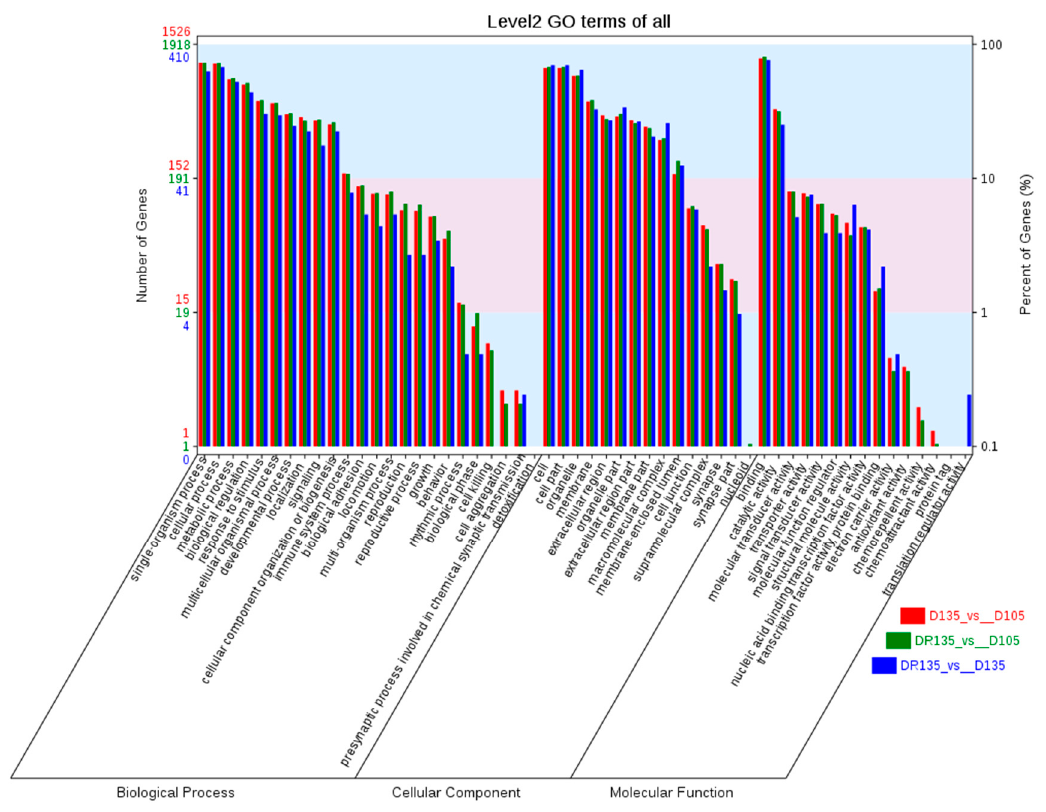
Figure 4. A Gene Ontology (GO) functional enrichment analysis of DEGs. The x-axis shows the three categories of Gene Ontology; the y-axis shows the number of genes (left) and percent of genes (right). The red bars represent DEGs number in D135 vs. D105. The green bars represent DEGs number inDR135 vs. D105 and Blue bars represent DEGs number inDR135 vs. D135.